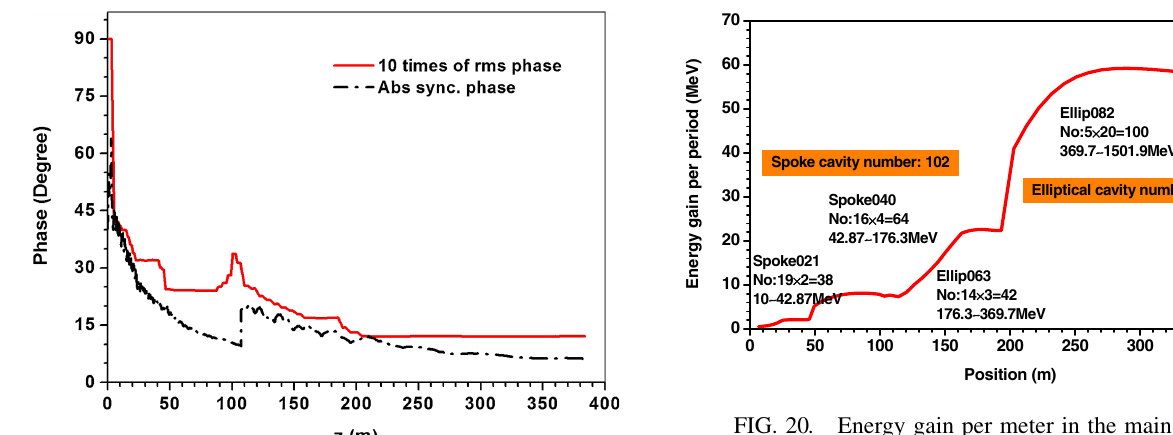
FIG. 20. Energy gain per meter in the main linac.